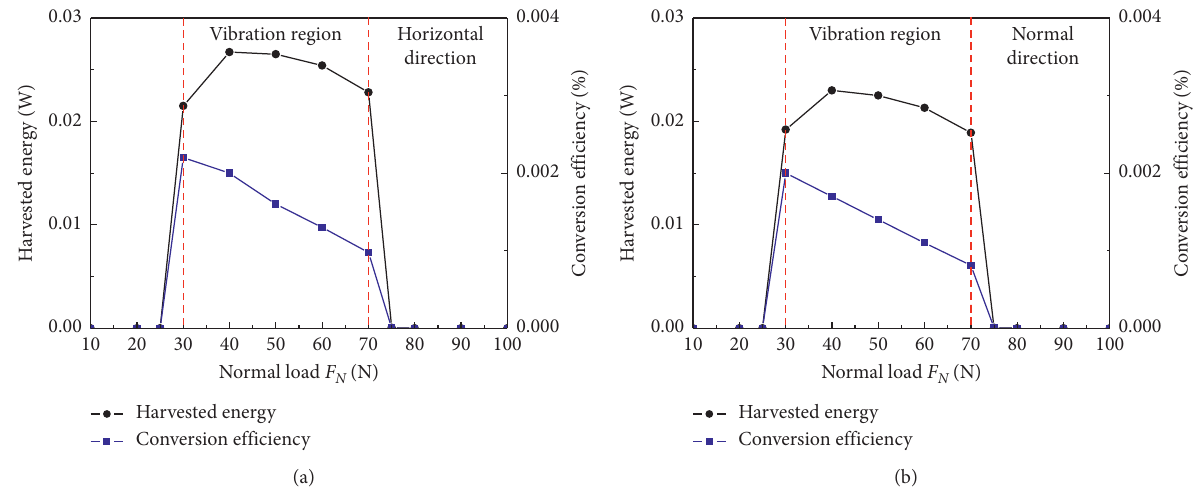
Figure 23: Ignoring separation, the harvested energy and conversion efficiency of the friction system in the horizontal direction (a) and normal direction (b) with different normal loads.